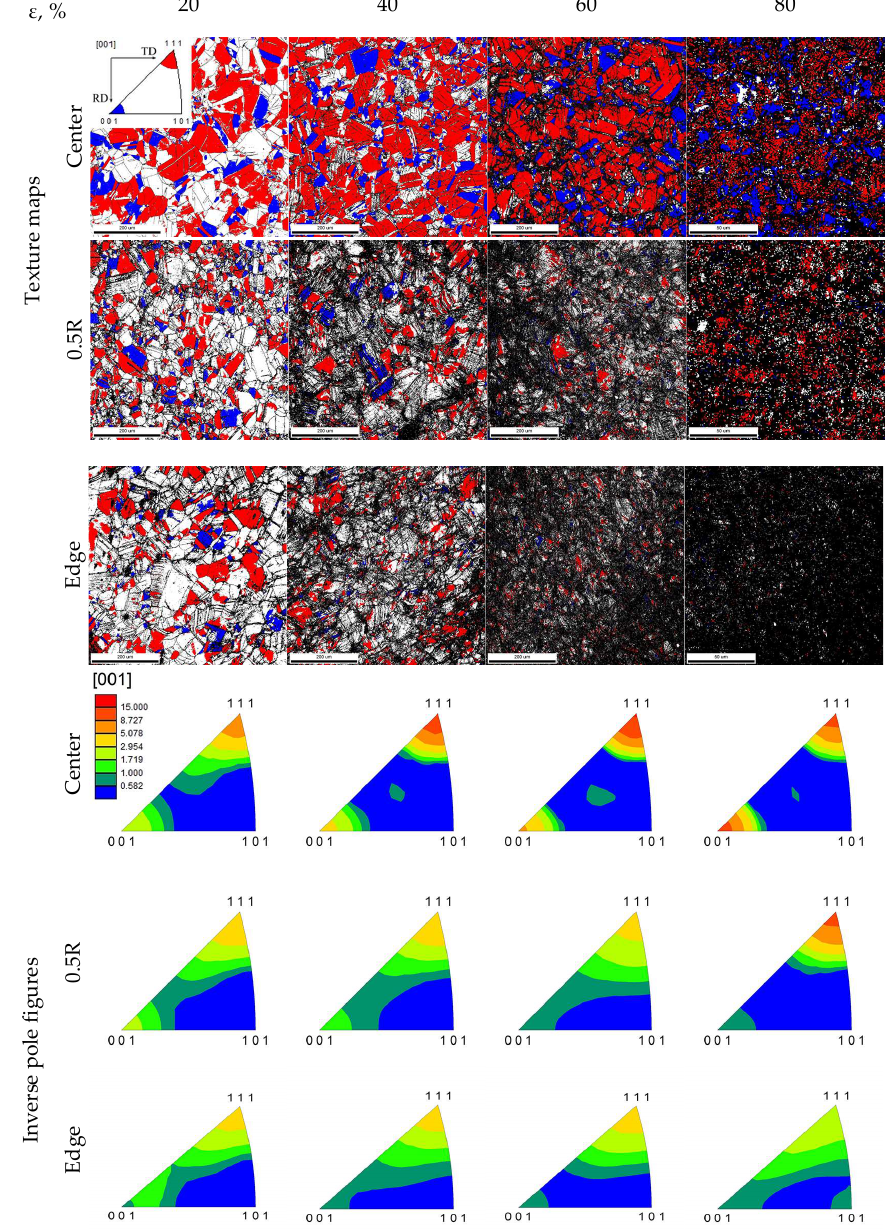
Figure 3. Texture maps and corresponding inverse pole figures after different swaging modes.